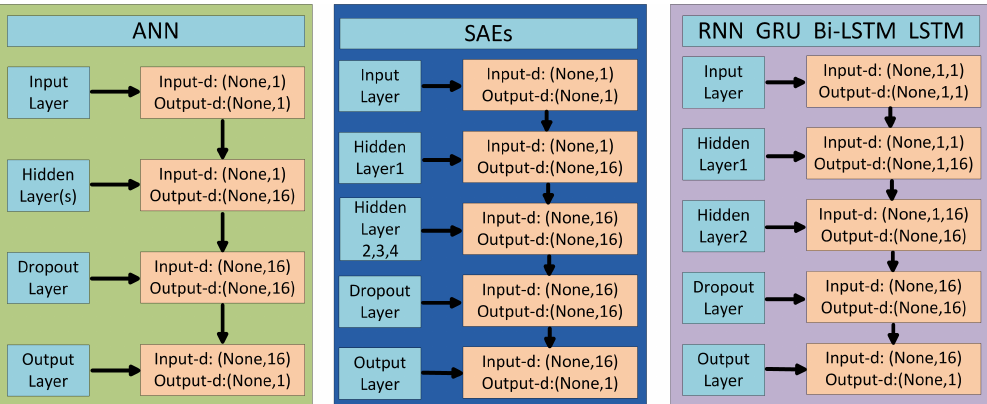
Figure 8. Dimension conversion in each layer.